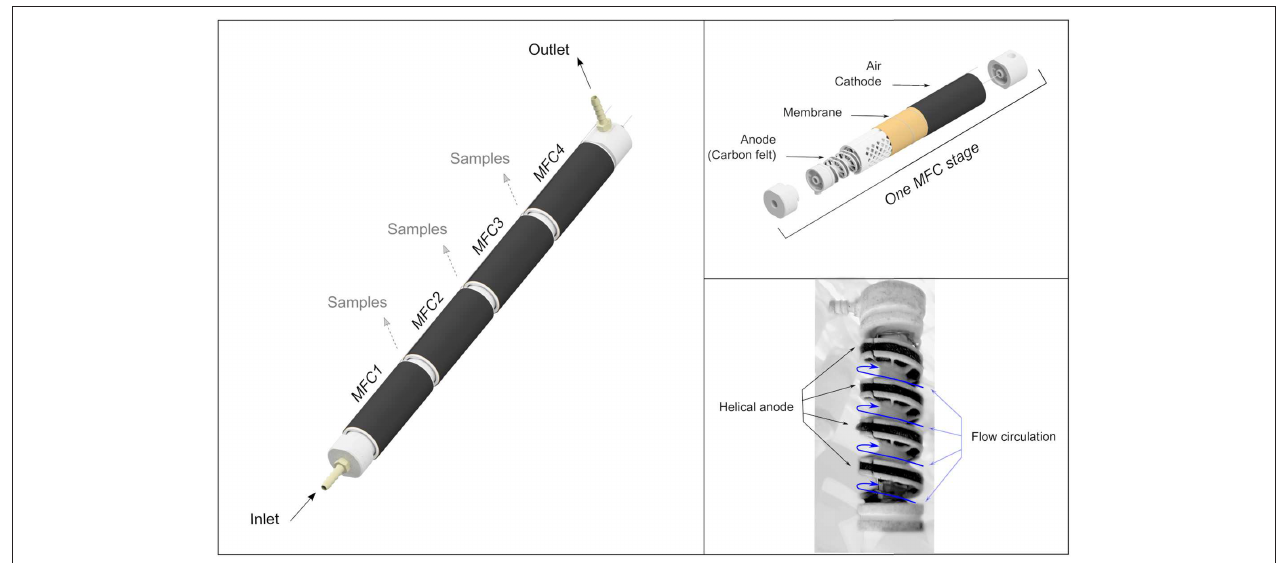
FIGURE 1 | Schematic of the tubular reactors composed of four MFCs with a helical anodic